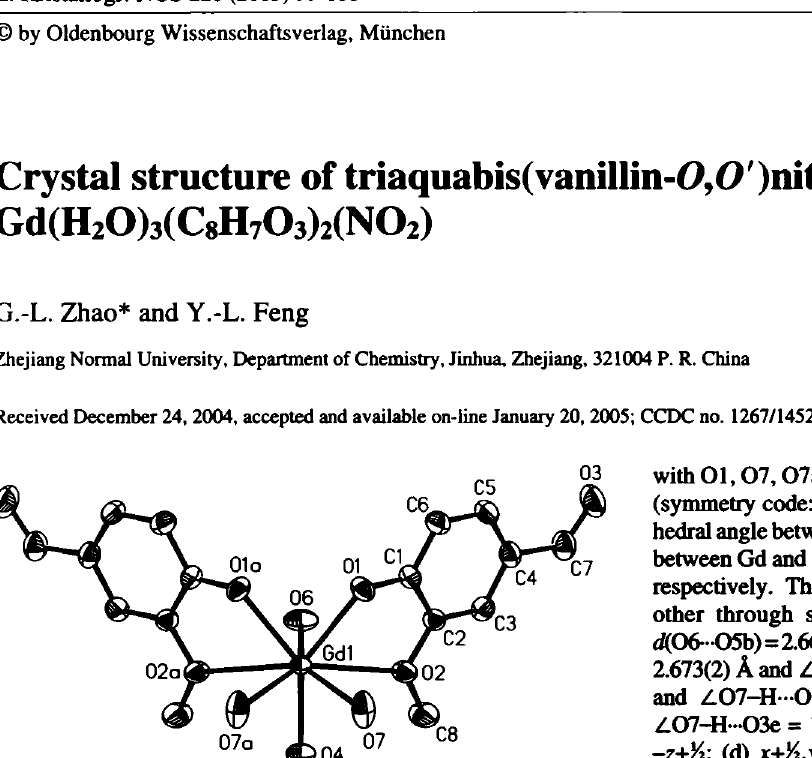
Table 1. Data collection and handling. Crystal: